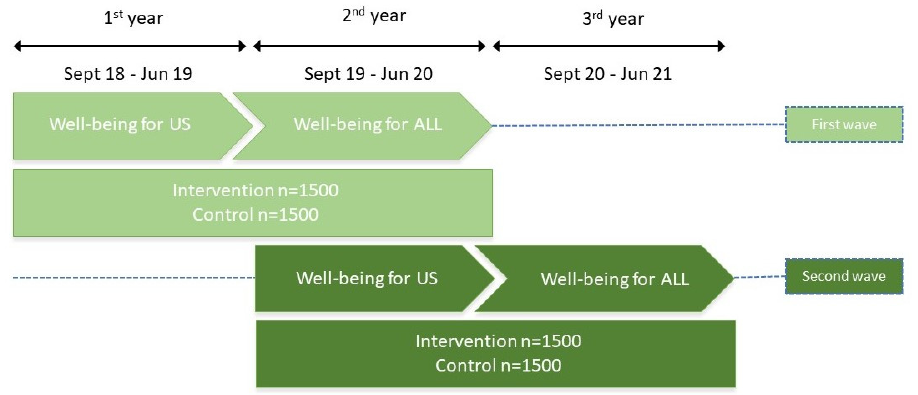
Figure 2. UPRIGHT overall implementation phases.